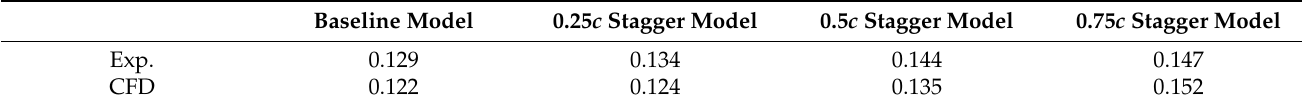
Table 3. Lift slopes of the staggered models ( ± 10